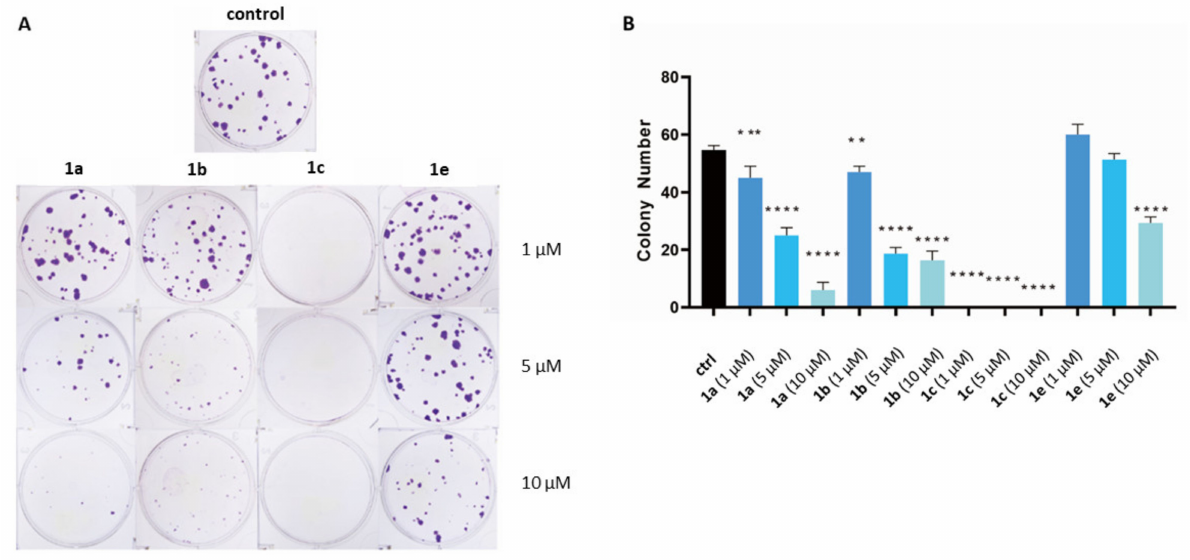
Figure 1. Left figure: Colony formation assays revealed a dose-dependent inhibition of HepG2 colony formation after 14 days of incubation with 1a , 1b , 1c and 1e . Right figure: mean values ± SD of colony numbers of n = 3 experiments. Statistical significance was tested by one-way ANOVA, ** p < 0.01, *** p < 0.001, **** p <